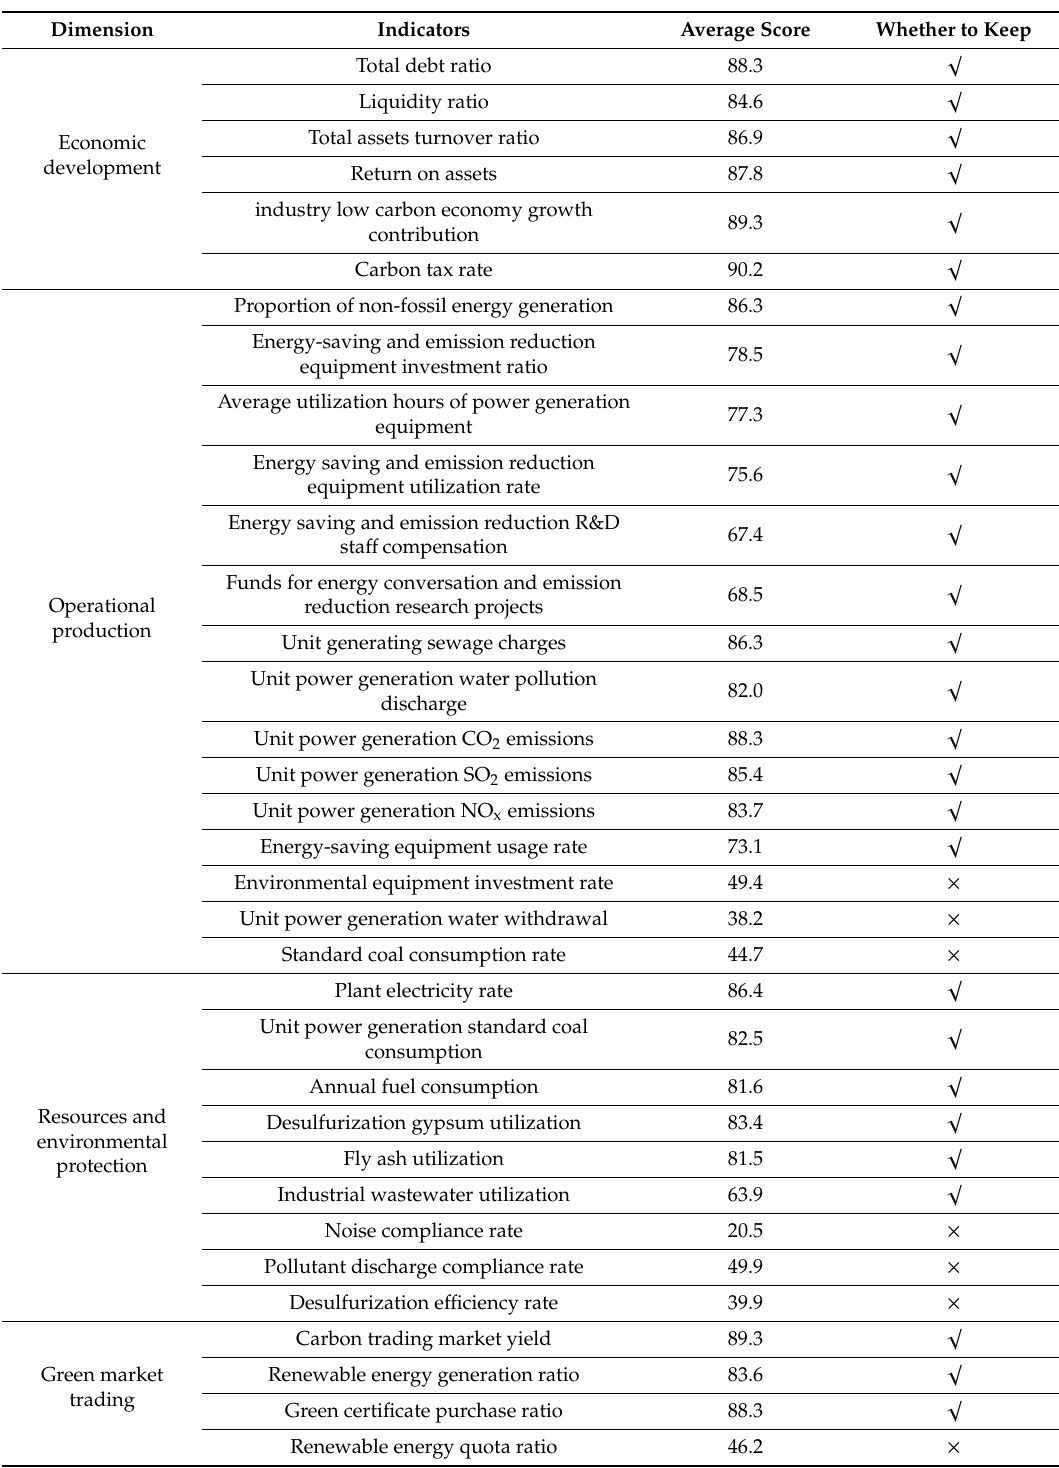
Table A1. Average scores of preliminary